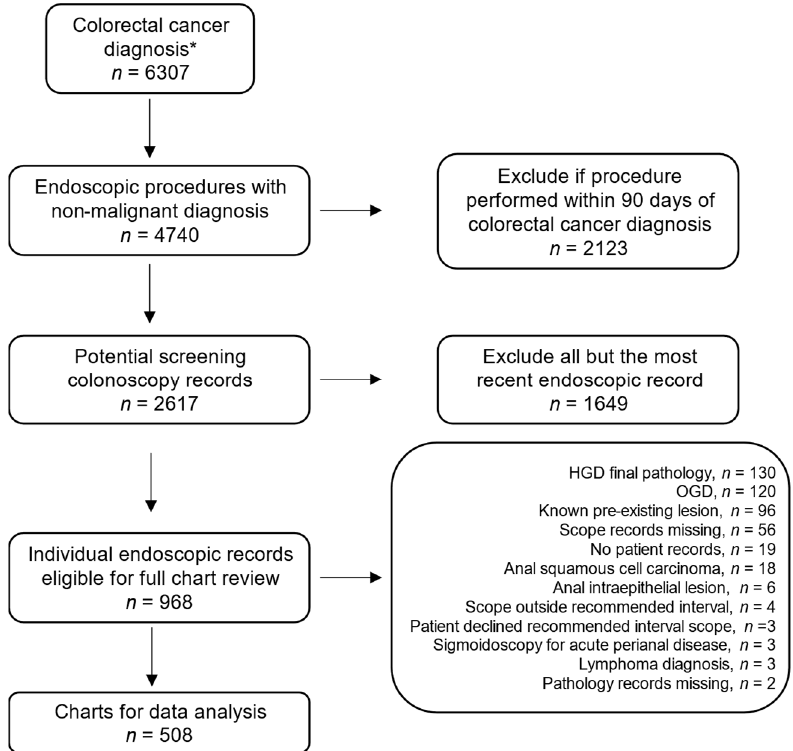
Figure 1. Flow chart of this study design with exclusion criteria. * Health charts numbers from 6307 patients with a colorectal cancer diagnosis where then searched for endoscopic procedures, which returned 4740 endoscopic records for further investigation. HGD, high grade dysplasia; OGD, oesophagogastroduodenoscopy (upper endoscopy).